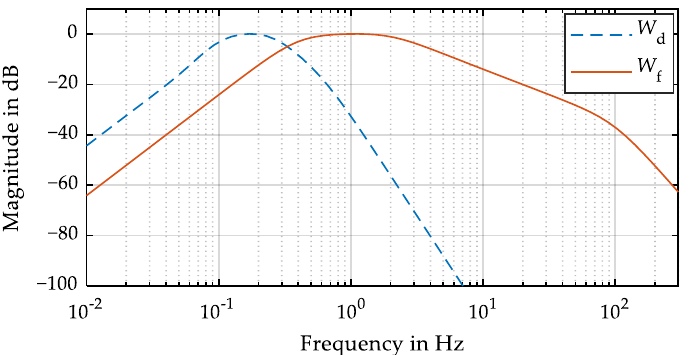
Figure 3. Frequency weighting curves for comfort and motion sickness [49].